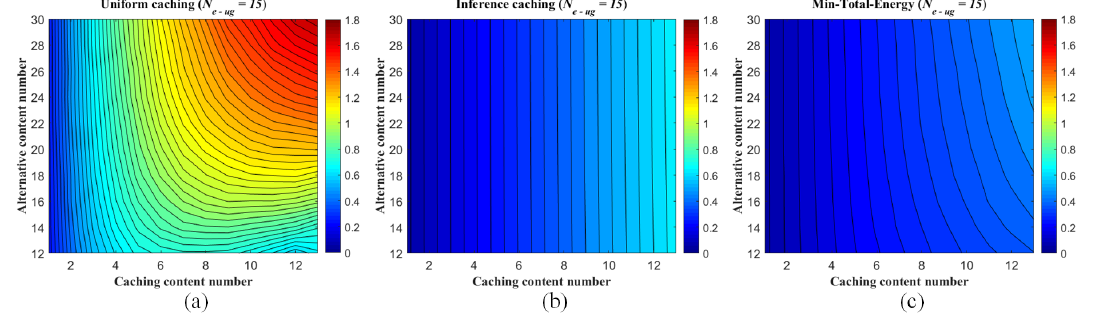
Figure 8. Average energy consumption of each eRRH in the F-RAN on the synthetic dataset (measured as J due to J = W · sec). Two different edge caching strategies are considered: (i) uniform caching strategy via content Zipf distribution, (ii) inferring caching strategy via pre-mapping (inferred by ANNMC with non-uniform sampling rate p s = 0.2) and Zipf distribution. The average energy consumptions of both strategies are compared with the minimum consumption E min − total . The range of the caching content number of each eRRH is varied from 2 to 12. The Zipf exponent s = 0,0.5,1,2, and ( a – d ) correspond to different s with N e − ug = 15, N cont = 15 and 25.